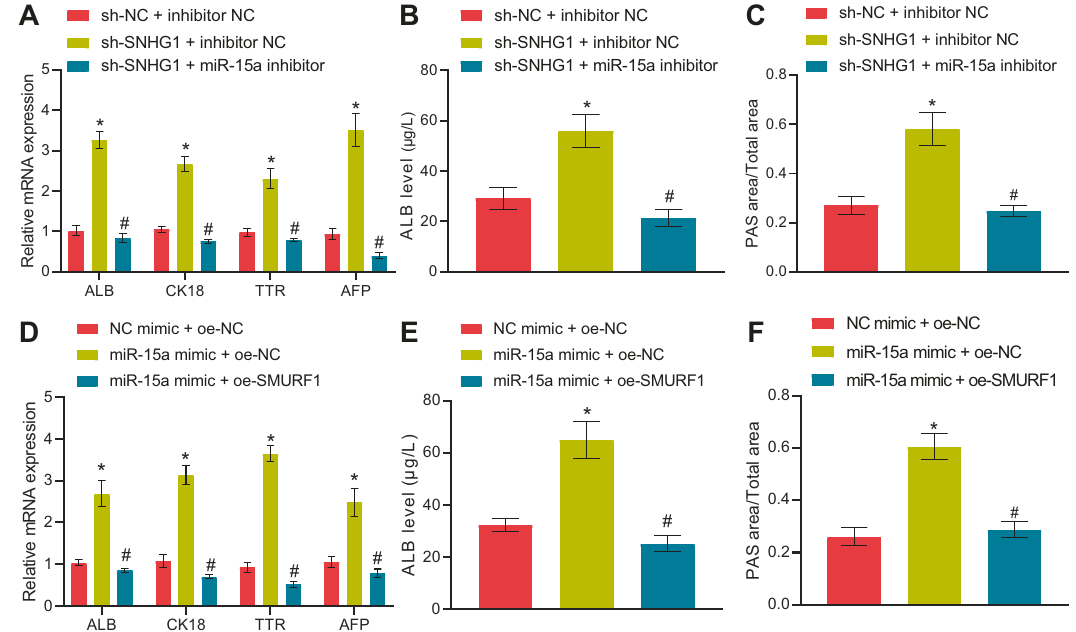
Fig. 6 LncRNA SNHG1 silencing orchestrates the miR-15a/SMURF1 axis to induce HLC differentiation of mouse BMSCs. A RT-qPCR to detect hepatocyte-related gene expression in differentiated BMSCs after silencing of lncRNA SNHG1 or/and inhibition of miR-15a for 14 days. B ELISA to detect ALB content in culture supernatant of BMSCs after silencing of lncRNA SNHG1 or/and inhibition of miR-15a for 14 days. C The glycogen accumulation in BMSCs after silencing of lncRNA SNHG1 or/and inhibition of miR-15a for 14 days determined by PAS staining. D RT-qPCR to assess hepatocyte-related gene expression in differentiated BMSCs after overexpressing miR-15a or/and overexpressing SMURF1 for 14 days. E ELISA to assess ALB content in culture supernatant of BMSCs after overexpressing miR-15a or/and overexpressing SMURF1 for 14 days. F Glycogen accumulation in BMSCs after overexpression of miR-15a or/and overexpression of SMURF1 for 14 days evaluated by PAS staining. * p < 0.05 vs . BMSCs transfected with sh-NC + inhibitor NC/NC mimic + oe-NC; # p < 0.05 vs . BMSCs transfected with sh-SNHG1 + inhibitor NC/miR-15a mimic + oe-NC. The cell experiments were repeated three